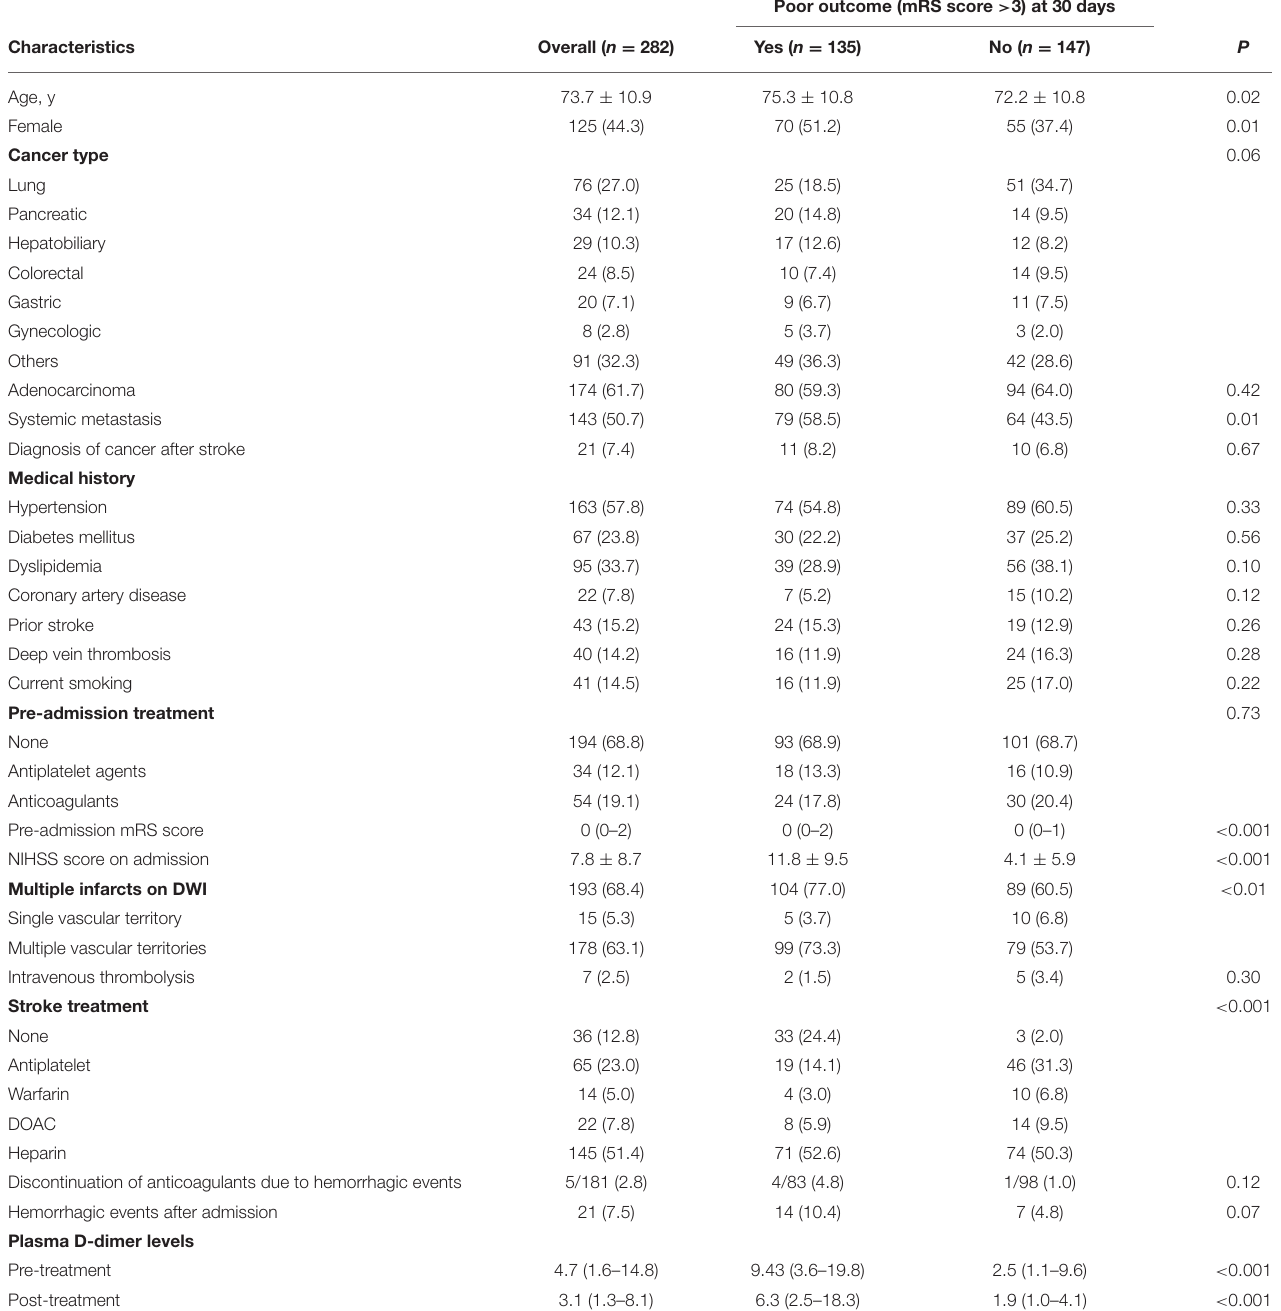
TABLE 1 | Clinical characteristics of patients according to outcomes 30 days after